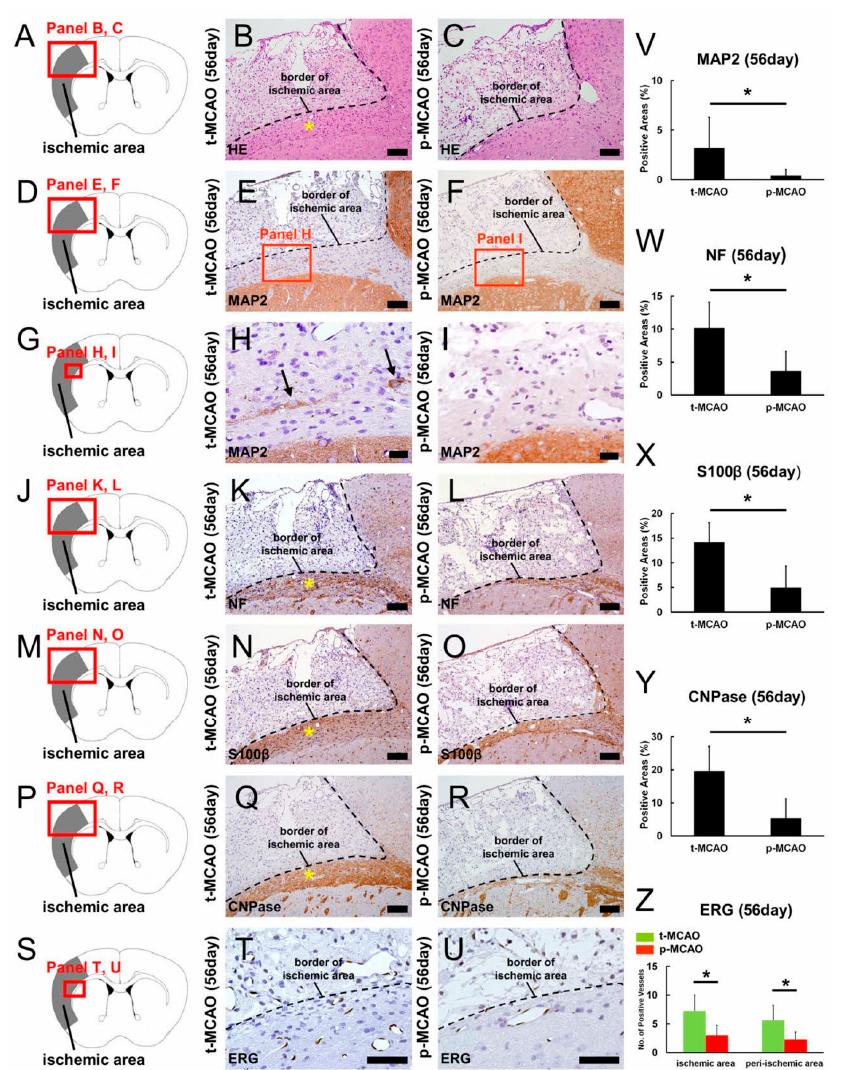
Figure 6. H&E staining ( A - C ) obtained 56 d after 90-min t-MCAO ( B ) and p-MCAO ( C ). The tissues around the ischemic area border were thicker after 90-min t-MCAO compared to p-MCAO ( B , asterisk). Immunohistochemistry for MAP2 ( D – I ), neurofilament ( J – L ), S100 β ( M – O ), and CNPase ( P – R ) at 56 d post stroke revealed that these neural markers were more prominent after 90-min t-MCAO (MAP2 + neurons ( E , H , arrows), NF + neurons ( K , asterisk), S100 β + astrocytes ( N , asterisk), CNPase + oligodendrocytes ( Q , asterisk)) compared to p-MCAO (MAP2 + neurons ( F , I ), NF + neurons ( L ), S100 β + astrocytes ( O ), CNPase + oligodendrocytes ( R )). Immunohistochemistry at 56 d post stroke showed that more ERG + endothelial cells ( S – U ) were observed after 90-min t-MCAO ( T ) compared to p-MCAO ( U ). Quantitative analysis showed that peri-ischemic areas positive for MAP2 ( V ), neurofilament ( W ), S100 β ( X ), and CNPase ( Y ) markers were significantly larger after 90-min t-MCAO compared to p-MCAO. Quantitative analysis showed that the number of ERG + vessels within and peri-ischemic areas was significantly greater after 90-min t-MCAO compared to p-MCAO ( Z ). Results are representative of three replicates. Scale bars = 100 µ m ( B , C , E , F , K , L , N , O , Q , R ), 20 µ m ( H , I ), and 50 µ m ( T , U ). * p < 0.05 between stroke models (90-min t-MCAO vs. p-MCAO) ( V – Z ) ( n = 3, for each model). Abbreviations: CNPase, 2’,3’-Cyclic-nucleotide 3’-phosphodiesterase; ERG, ETS-related gene; GFAP, glial fibrillary acidicprotein; H&E,hematoxylinandeosin; MAP2, microtubule-associatedprotein2; NF,neurofilament; p-MCAO, permanent middle artery occlusion; t-MCAO, transient middle cerebral artery